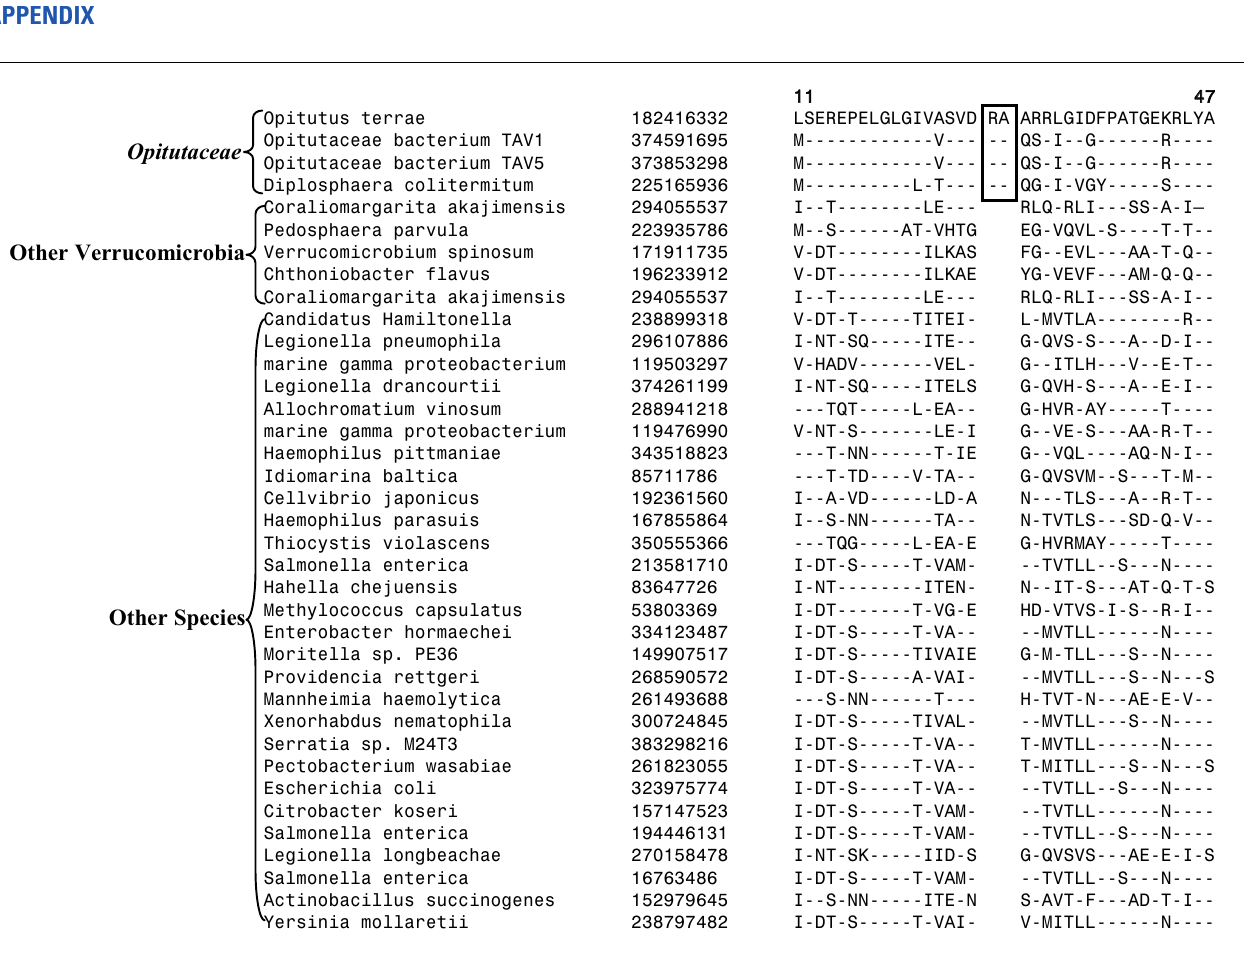
FIGUREA1 | Partial sequence alignment of the helicase domain-containing protein showing 2 aa insert that is specific for the family Opitutaceae. The insert in not present in otherVerrucomicrobia or in any other group of